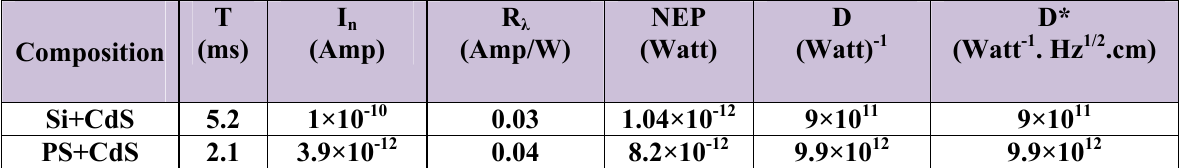
Table 3: The figure of merit for CdS nanostructure photodetector. T Composition Si+CdS